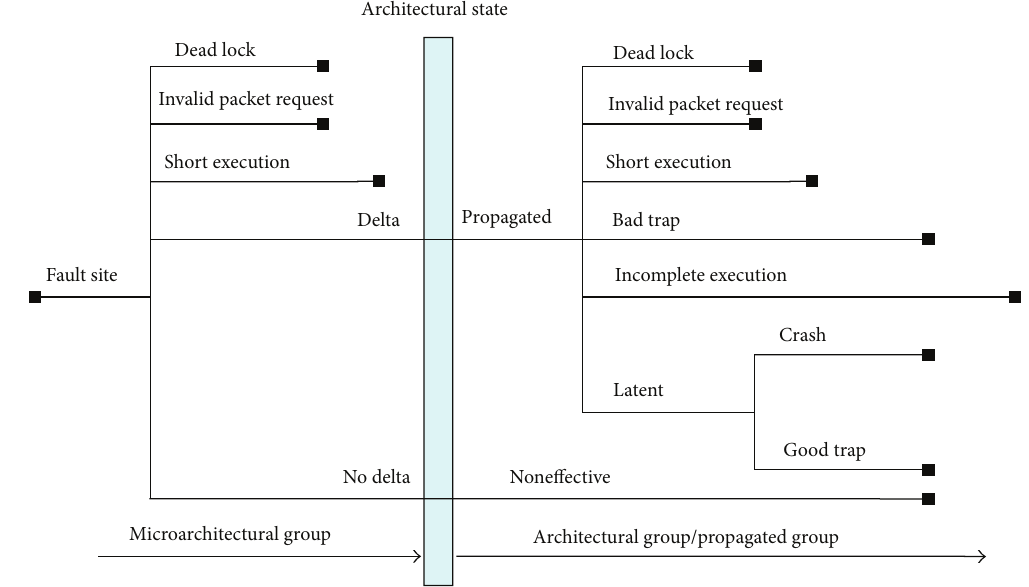
Figure 2: Outcome categories: microarchitectural level groups versus propagated groups. Table 9: Detectable